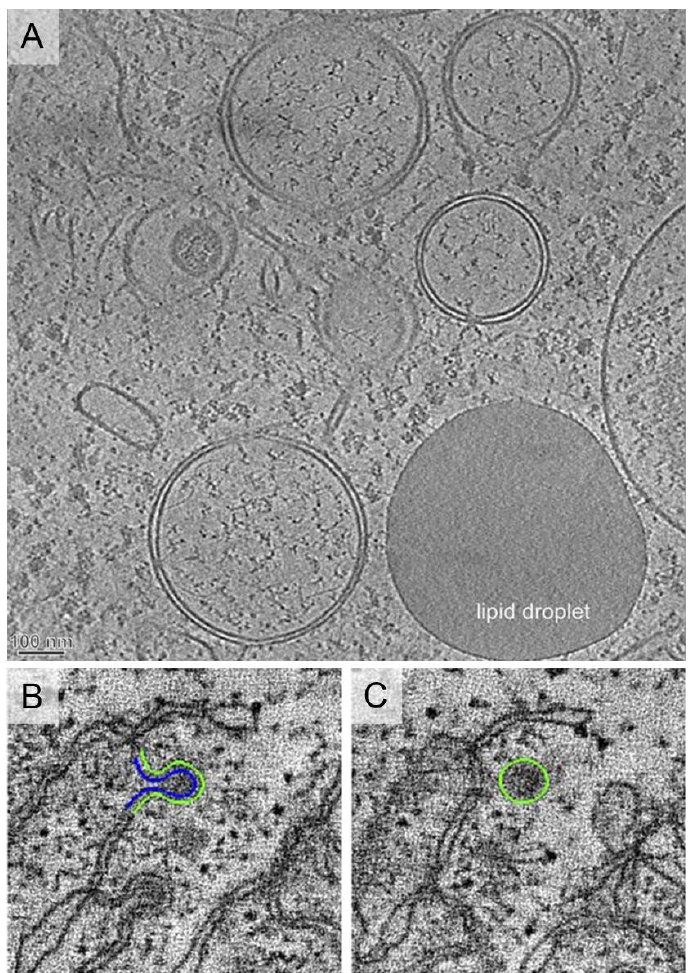
Figure 4. Ultrastructure of viral vesicles. ( A ) Endoplasmic Reticulum (ER)-derived double membrane vesicles (DMV) generated by positive-strand RNA viruses such as Hepatitis C virus (HCV), or severe acute respiratory syndrome coronavirus (SARS-CoV). Image reproduced, with permission, from [62]. Scale bar, 100 nm. ( B , C ) Single-membrane spherules formed by brome mosaic virus that localize inside the ER membranes. Images reproduced, with permission, from [66] .